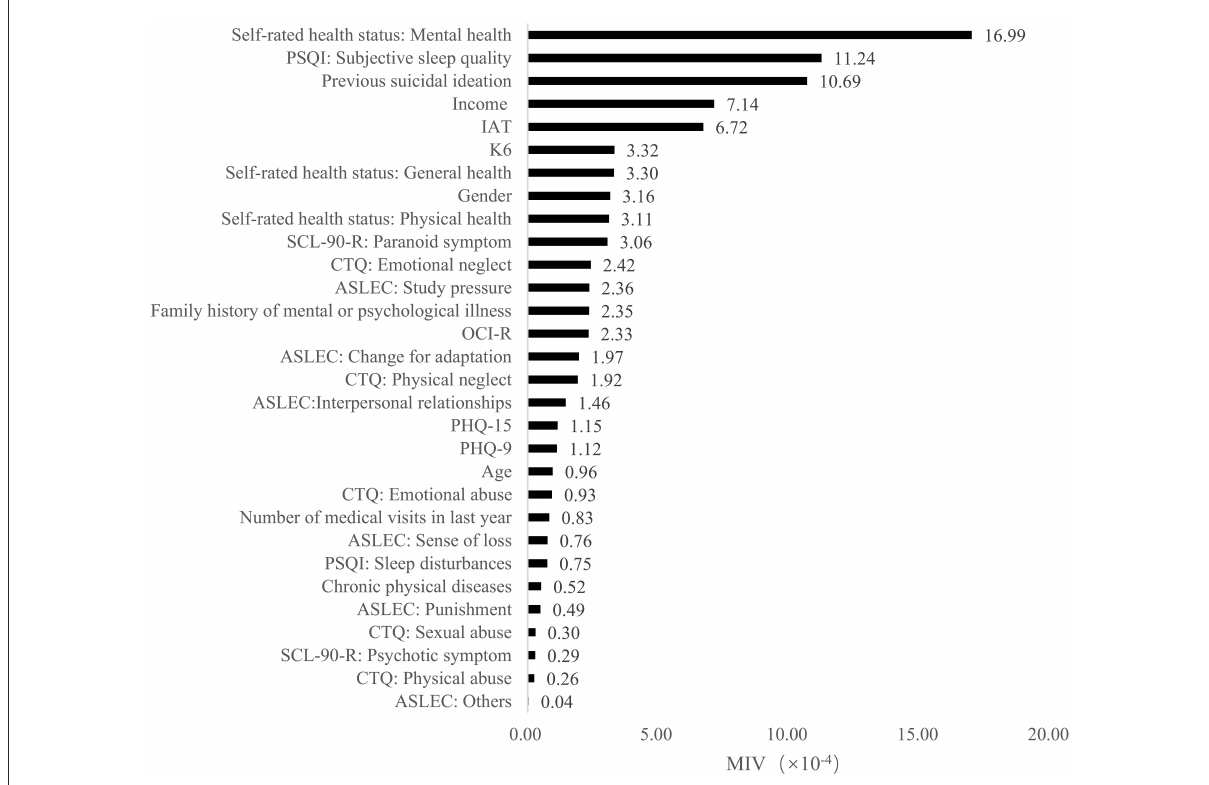
FIGURE3 The mean impact values of independent variables in model